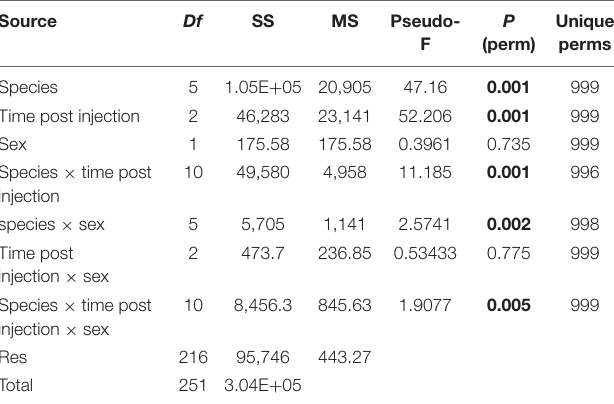
TABLE 1 | PERMANOVA results table for tsetse species, time post GpSGHV injection and sex and their combinations. Source Df Pseudo-